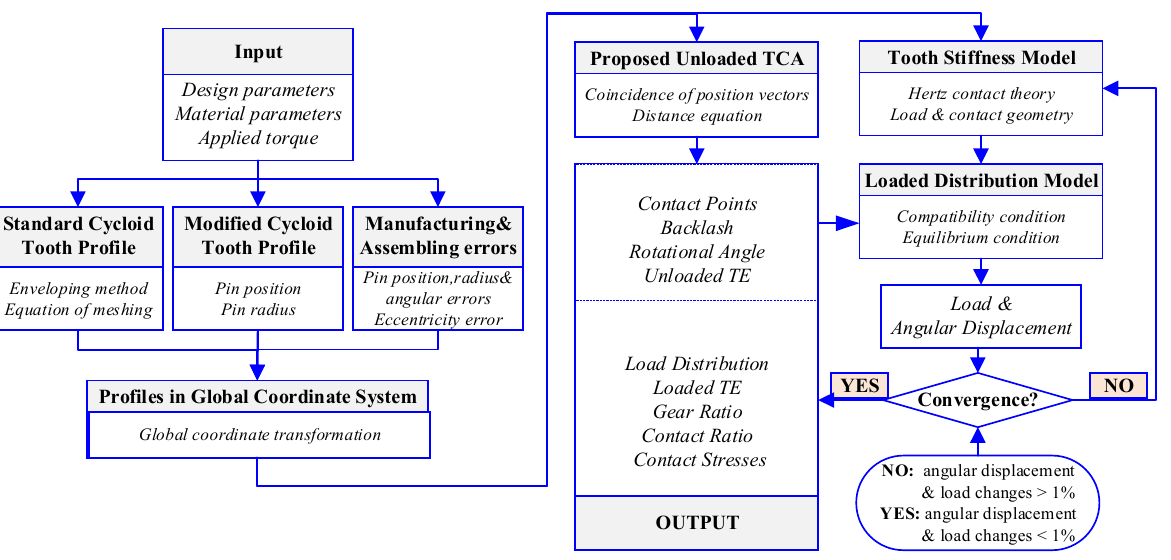
Figure 4. Flowchart of the load distribution analysis for the cycloid-pin gear pair.